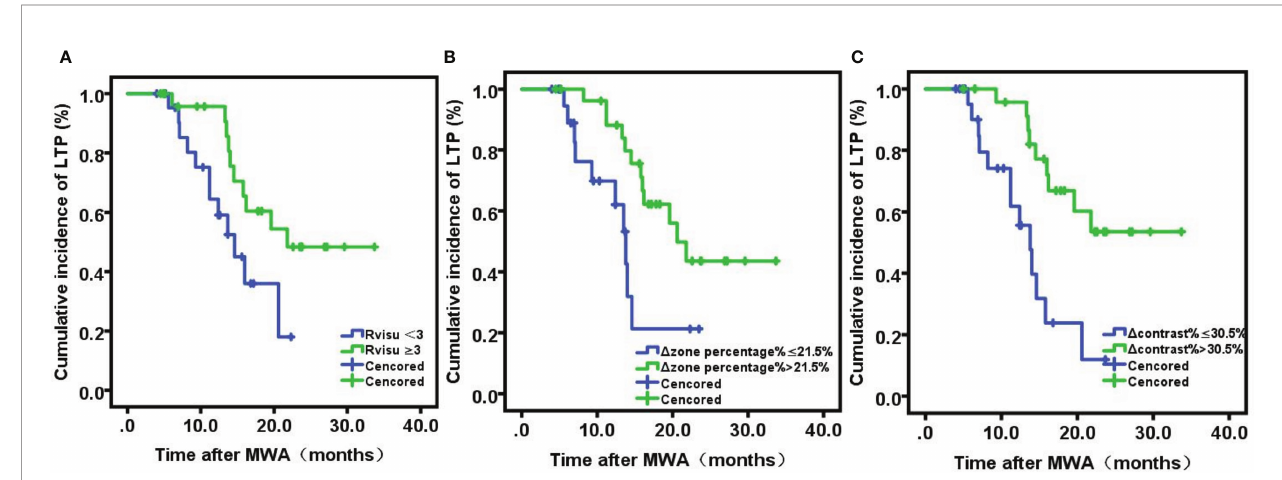
FIGURE 4 | Kaplan-Meier analyses of local tumor progression. (A) Viusal Score; (B) D Zone percentage%; (C) D :